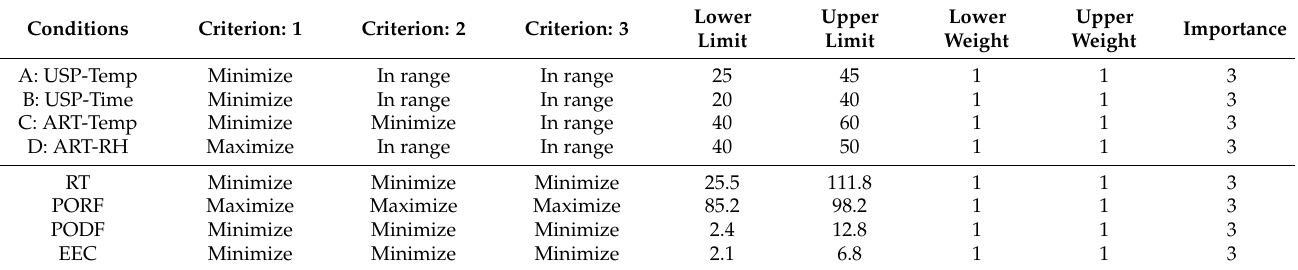
Table 4. Constraints for optimizing ripening time (RT), percentage of ripe fruit (PODF), percentage of damaged fruit (PODF), and electrical energy consumption (EEC) under three criteria.